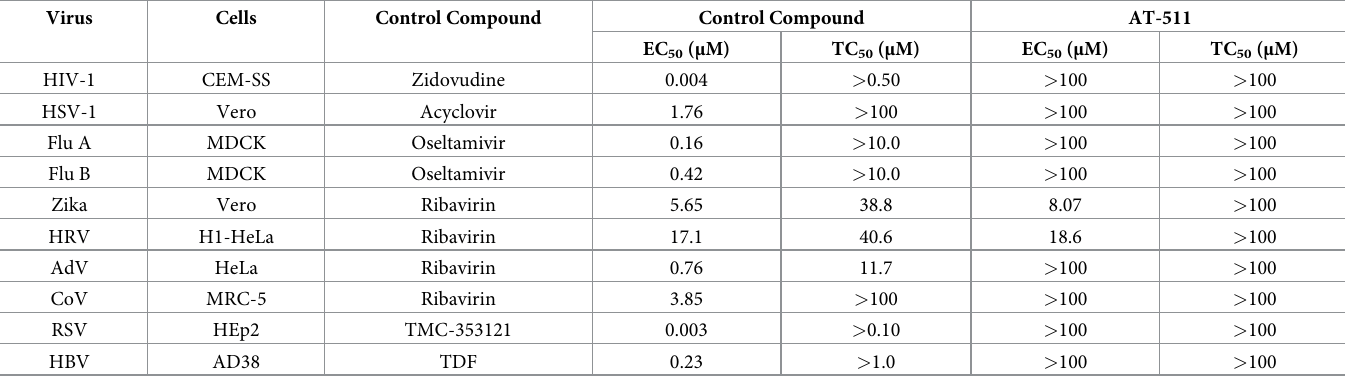
Antiviral activity and cell viability were measured as described in the Methods.